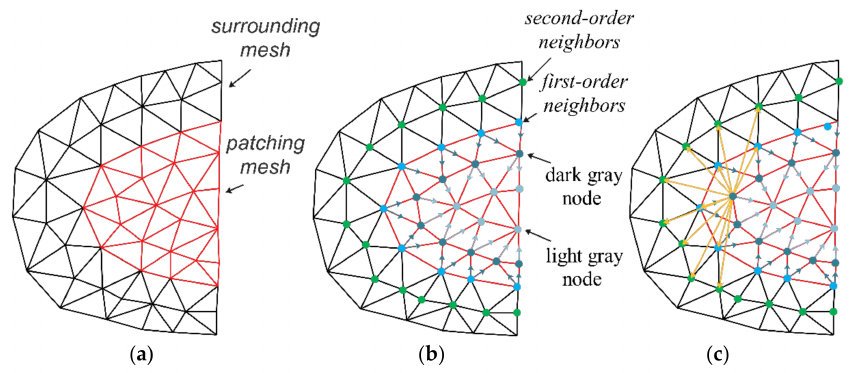
Figure 9. Mesh Adjustment: ( a ) mesh refinement; ( b ) adjacent point extraction; ( c ) mesh